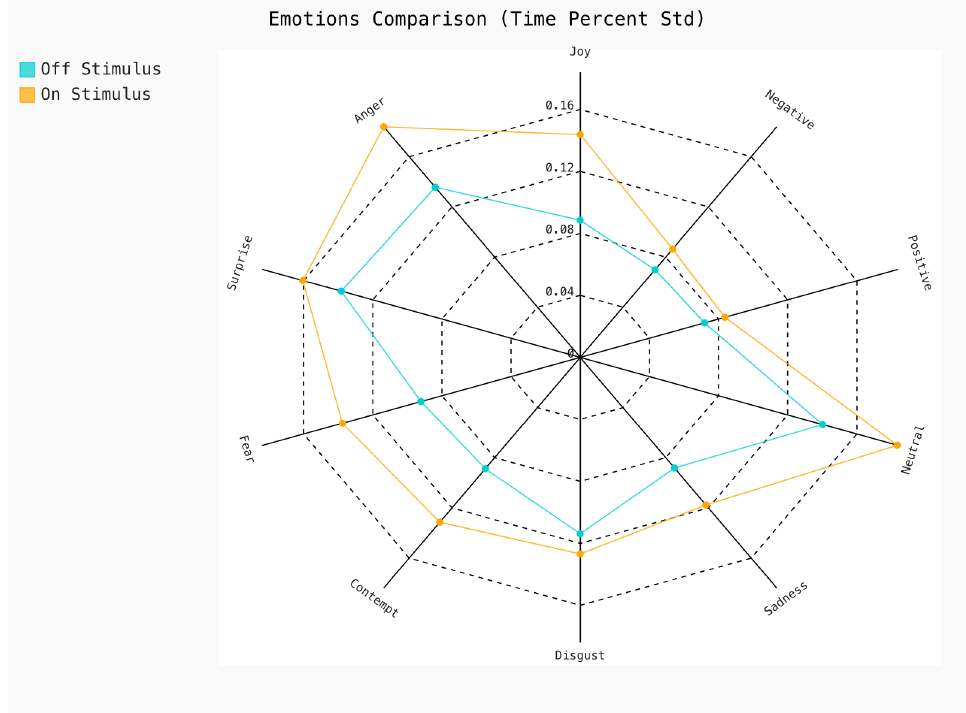
Figure 10. Comparison of the standard deviation of the percentage of observable time for each emotion between dynamic web design—on-stimulus—and static web